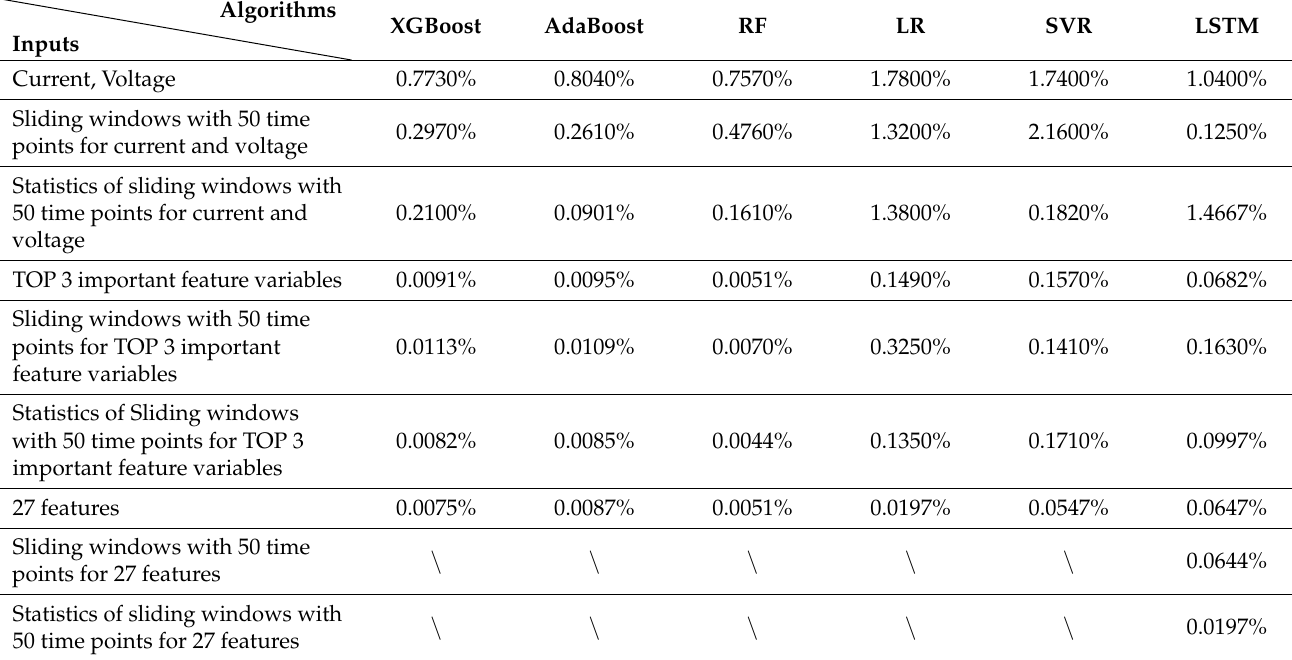
Table 3. Comparison of algorithms’ MAE when selecting different input variables.